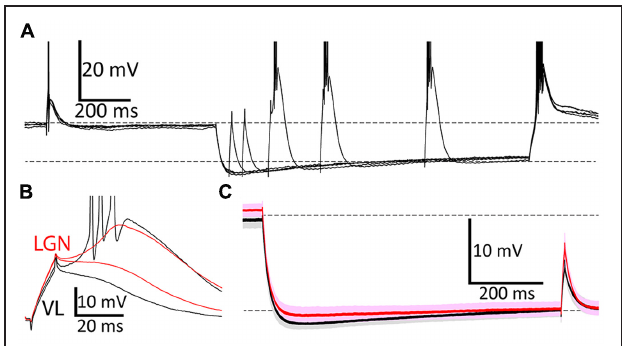
FIGURE 2 | Voltage responses during the DCSW protocol. (A) During each of five overlaid ‘sweeps’ in a neuron in VL, membrane potential was near − 65 mV (for 2.0 s) before and after hyperpolarization to near − 80 mV by injection of an artificial conductance (10 nS for 1.2 s). Brief depolarizing currents (10 ms; 620 pA in this example) were injected from near − 65 mV (650 ms before hyperpolarization onset) and after delays of 50, 100, 200, 400, or 800 ms near − 80 mV. Dashed horizontal lines indicate − 65 and − 80 mV, here and in (C) . (B) Typical voltage responses from a neuron in VL (black; same cell as A ) and another in LGN (red) after 200 ms near − 80 mV to currents that were just above and below the threshold necessary to evoke a LTS. Three sodium spikes occurred in this response from VL, but their full extent is not shown. (C) Population average voltage in VL (black, n = 29) and LGN (red, n = 43), for the case of 200 pA injected at 800 ms after hyperpolarization. Darker and lighter shades indicate mean ± SEM and SD,